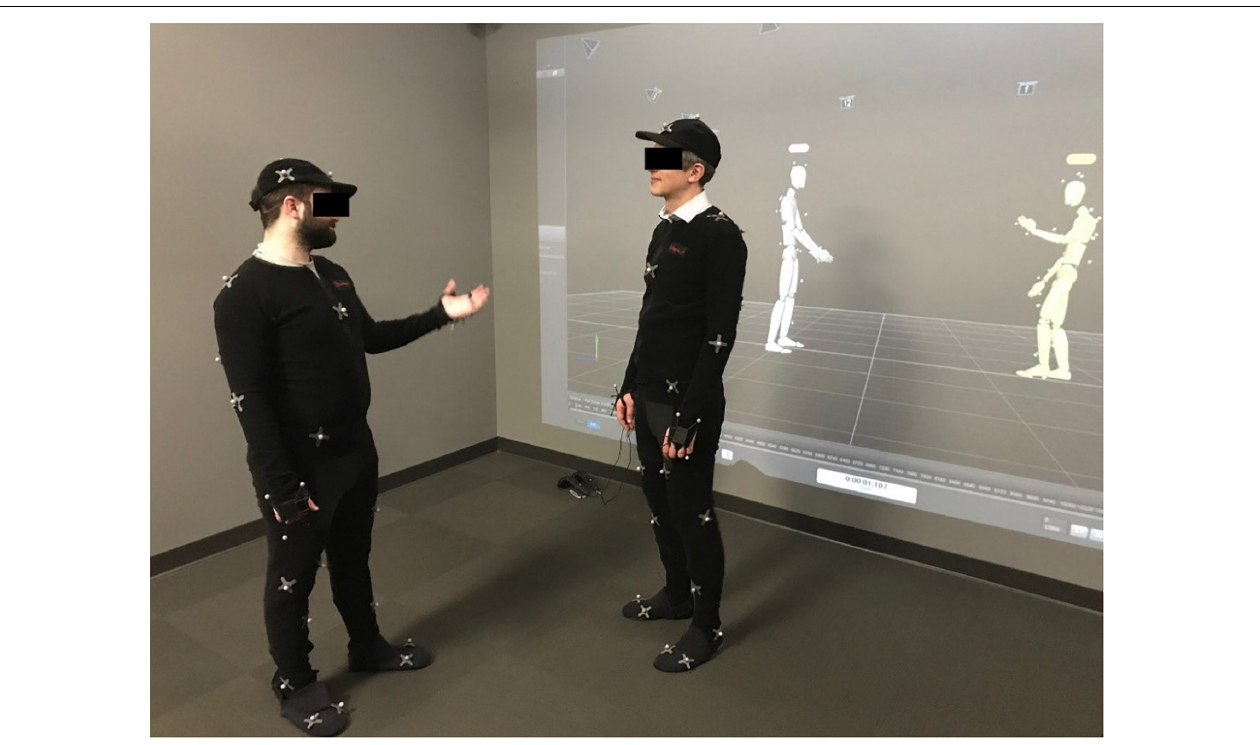
FIGURE 1 | Posed interaction showing the setup and the interface of the capture software as projection in the background (180 ◦ rotated).